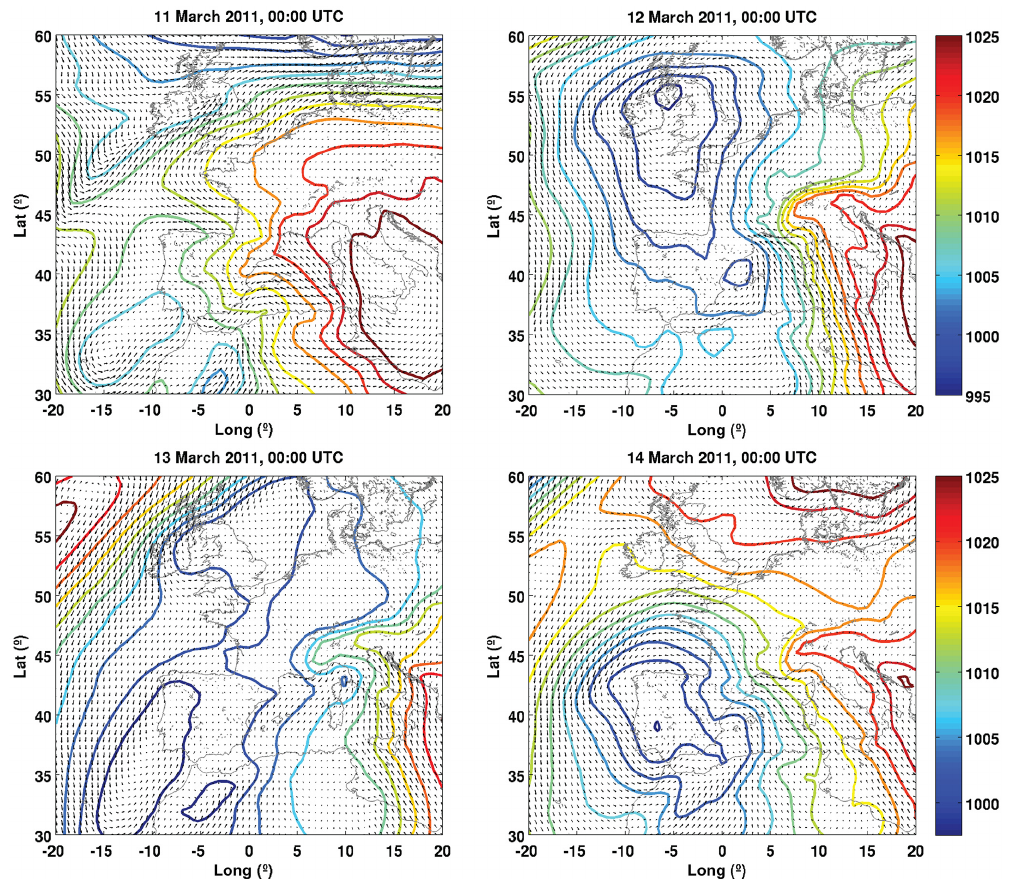
Figure 2. Regional charts of the mean sea-level pressure (HPa) and winds for the sequence 11–14 March 2011. Data source: ERA-Interim global reanalysis from